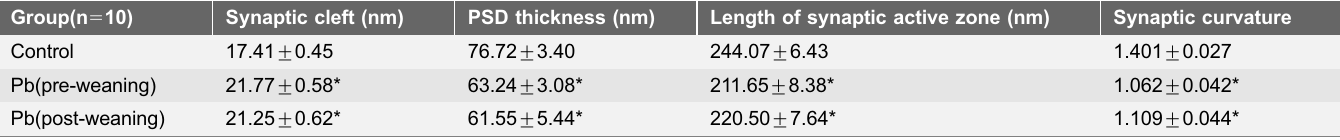
Table 5. The effect of developmental lead exposure on the synaptic structure parameters in the CA1 region of rat hippocampus on PND91. Group(n 5